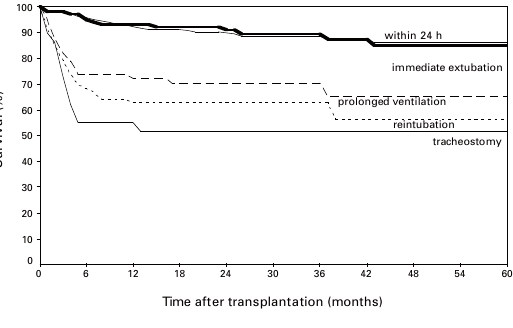
Survival of OLT pa- tients with reference to the time point of postoperative extubation (Charité, 1992–1996, n = 546 patients) [8]. Survival rate was significantly reduced in patients with prolonged ventilation when compared to early extubated patients (P <0.001).